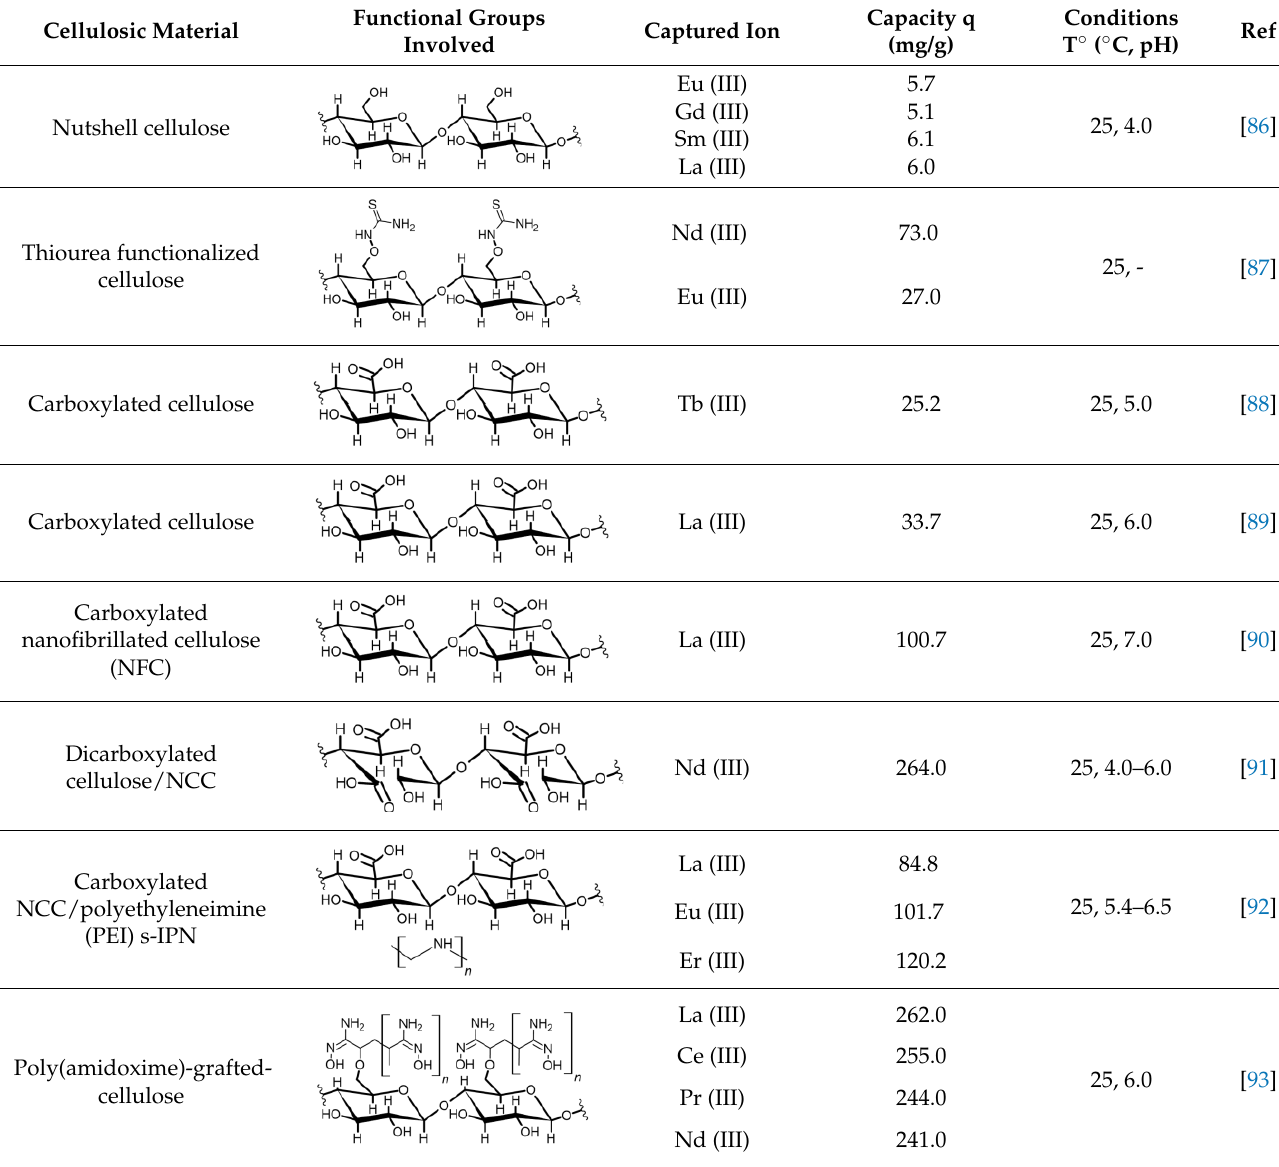
Table 3. Cellulosic materials for REE capture from aqueous media.